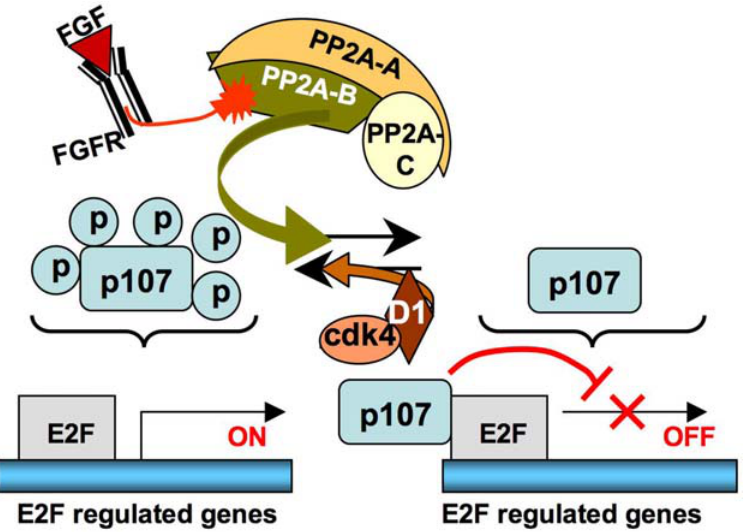
Figure 7. A model for FGF regulation of p107 phosphorylation in RCS cells. FGF signaling activates a regulatory B subunit that targets the PP2A holoenzyme to p107.